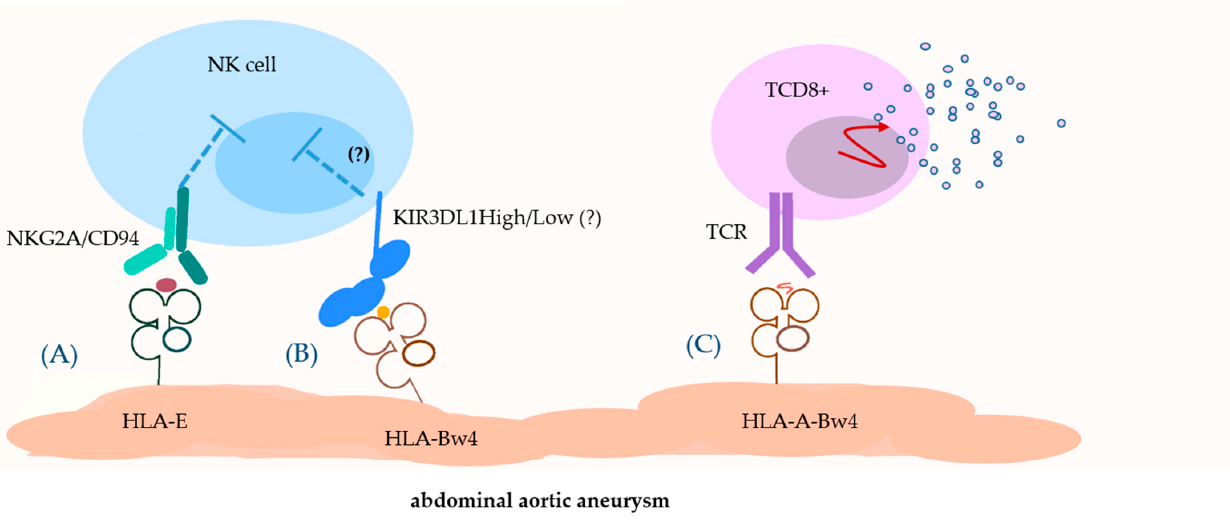
Figure 3. The scheme illustrating hypothetical role of HLA-A-Bw4 molecule and KIR3DL1 receptor in immunopathogenesis of AAA. ( A ) The non-classical HLA-E may display a peptide derived from the leader sequence of HLA-A molecules. HLA-E/HLA-A peptide complex interacts with NKG2A/CD94 on immune cells (NK, TCD8+) and drives their education. ( B ) The HLA-Bw4 (both HLA-A-Bw4 and HLA-B-Bw4) molecule interacts with KIR3DL1 and inhibits the activity of immune cells. ( C ) The HLA-A-Bw4 molecule presenting the aneurysmogenic peptide interacts with the TCR receptor, which leads to the activation of cytotoxic lymphocytes.